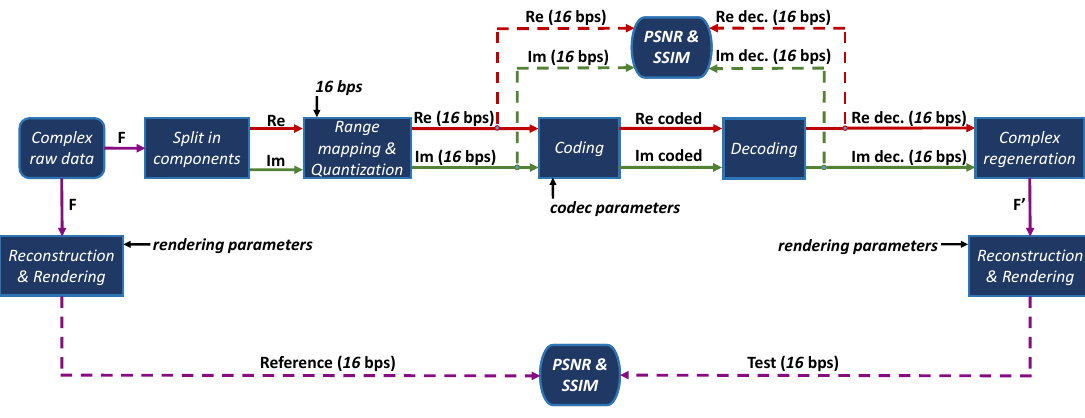
Figure 4. Compression